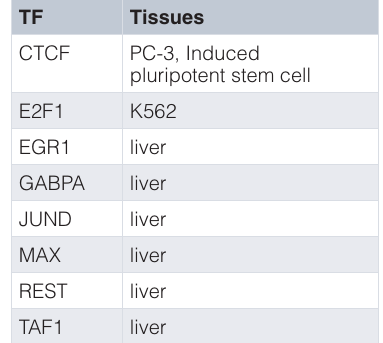
Table 2. Test data used in this article, shown per transcription factor (TF) and